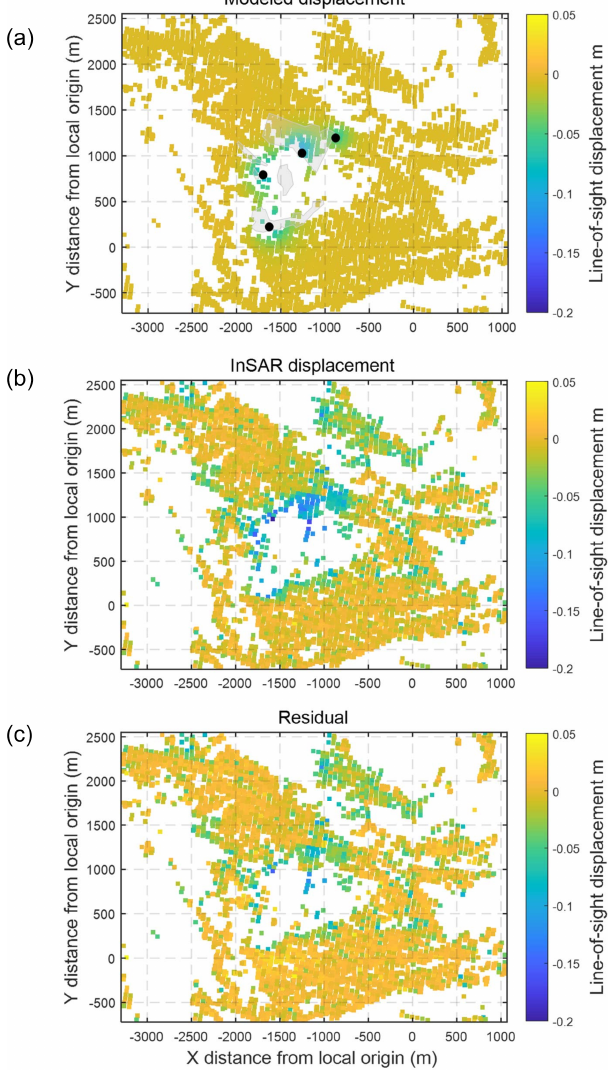
Figure 14. Cumulative LOS deformation (a) of the best-fitting model using four dislocation sources (black dots denote the location of source models; gray polygons show the mining area), (b) from the descending Sentinel-1 observation and (c) from residuals after subtracting the modeled displacement from the cumulative defor-